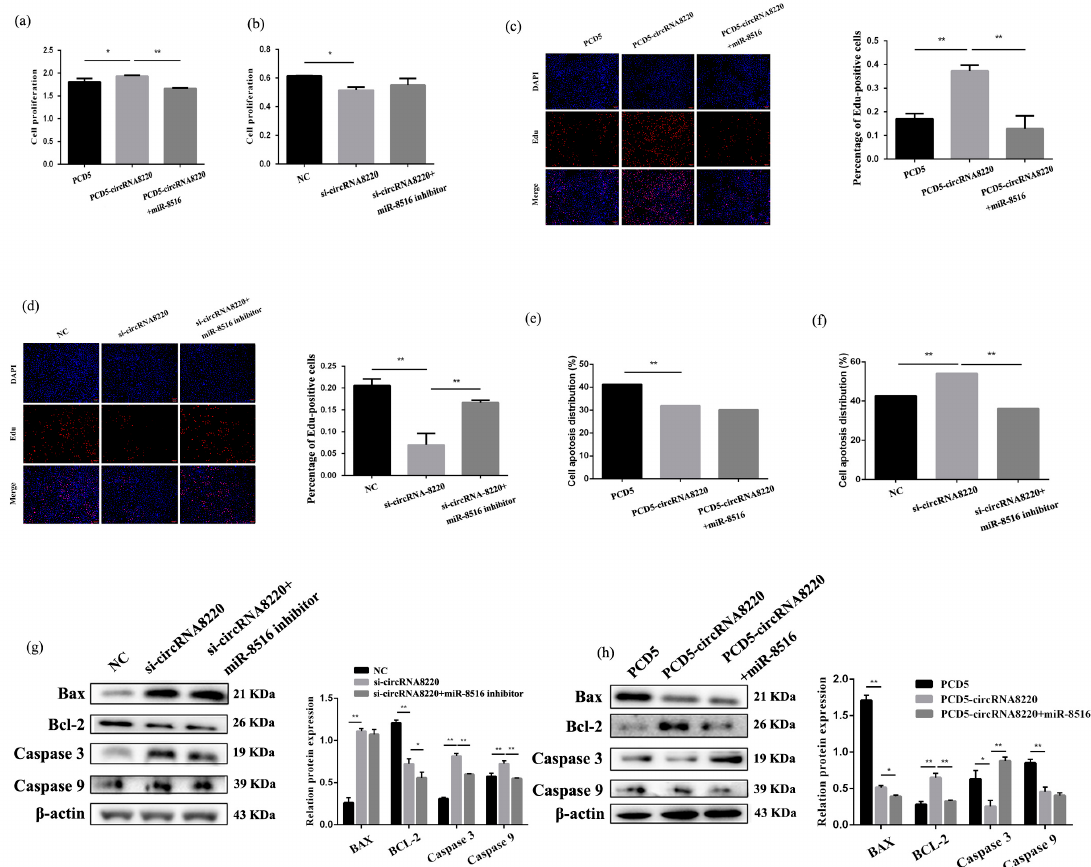
Figure 5. circRNA8220 inhibited apoptosis and promoted proliferation of GMEC in vitro. ( a , b ) Cell proliferation was assessed using the cell counting kit-8 (CCK-8) assay after transfection with PCD5-circRNA8220 or si-circRNA8220. ( c , d ) Cell proliferation indices were assessed after treatment with Edu after transfection with PCD5-circRNA8220 or si-circRNA8220. ( e , f ) Apoptosis analysis of GMEC was detected with FCM after transfection with PCD5-circRNA8220 or si-circRNA8220. ( g , h ) Protein levels of Bcl-2, Bax, caspase 3 and caspase 9 in GMEC after transfection with PCD5-circRNA8220 or si-circRNA8220. Protein levels were measured by WB densitometry was normalised to the β -actin density from the same lane. Data were expressed as the means ± SEM. ** p < 0.01, * p < 0.05. Apoptosis ratio was tested after transfection of pCD5-circRNA8220 or si-circRNA8220 by